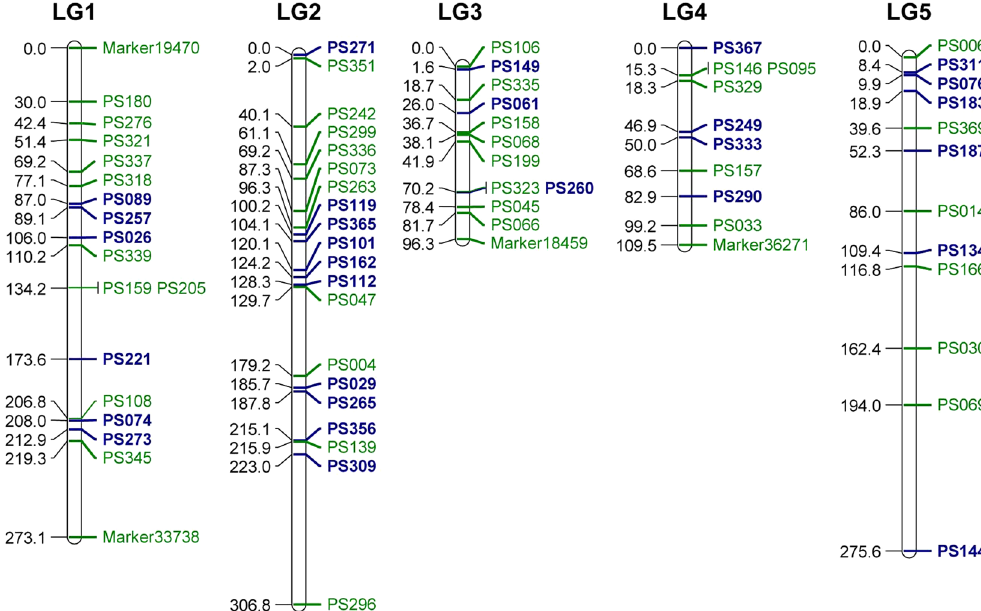
Figure 1. EST-SSR based genetic linkage map of tree peony. Blue indicate the 29 polymorphic markers of P. ostii used in this study. The names of the linkage groups are labeled on top, the genetic distances of the loci (cM) are shown on the right, and the names of loci are shown on the left of the linkage